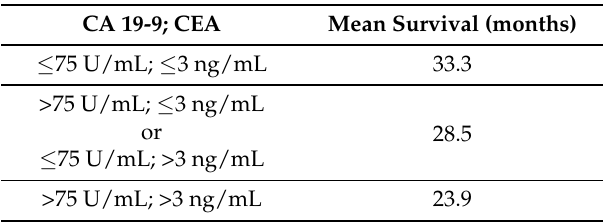
Table 2. Mean survival of patients based on preoperative elevation of CA 19-9 and carcinoembryonic antigen (CEA)